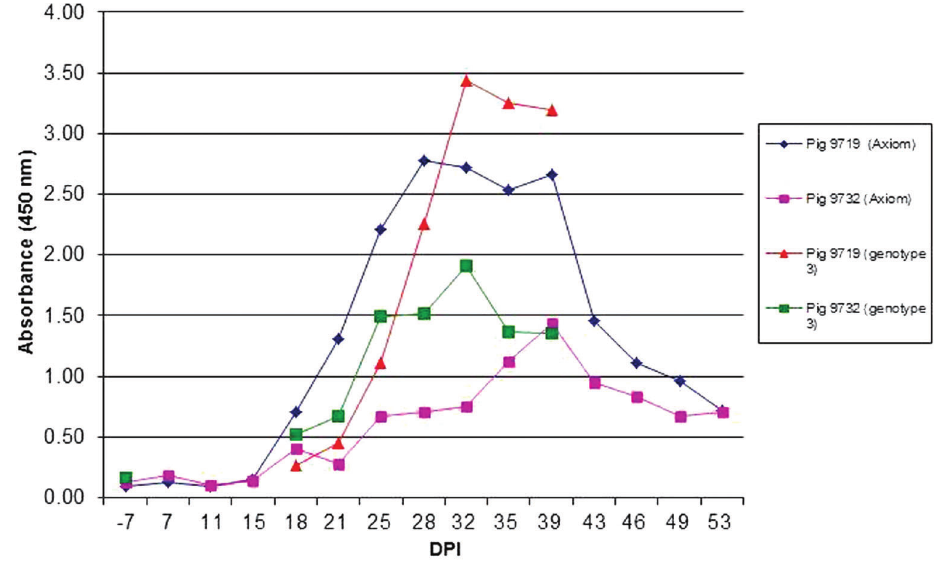
Figure 1. Hepatitis E virus genotype 3 (Gt3) antibody developments in experimentally HEV Gt3-infected pigs measured by HEV Gt3 ELISA CVI and HEV ELISA Axiom. Test procedures of the developed assay are described in Material and